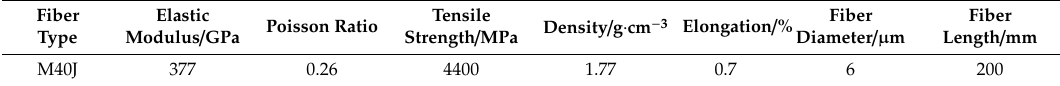
Table 2. Primary properties of the graphite fiber M40J.